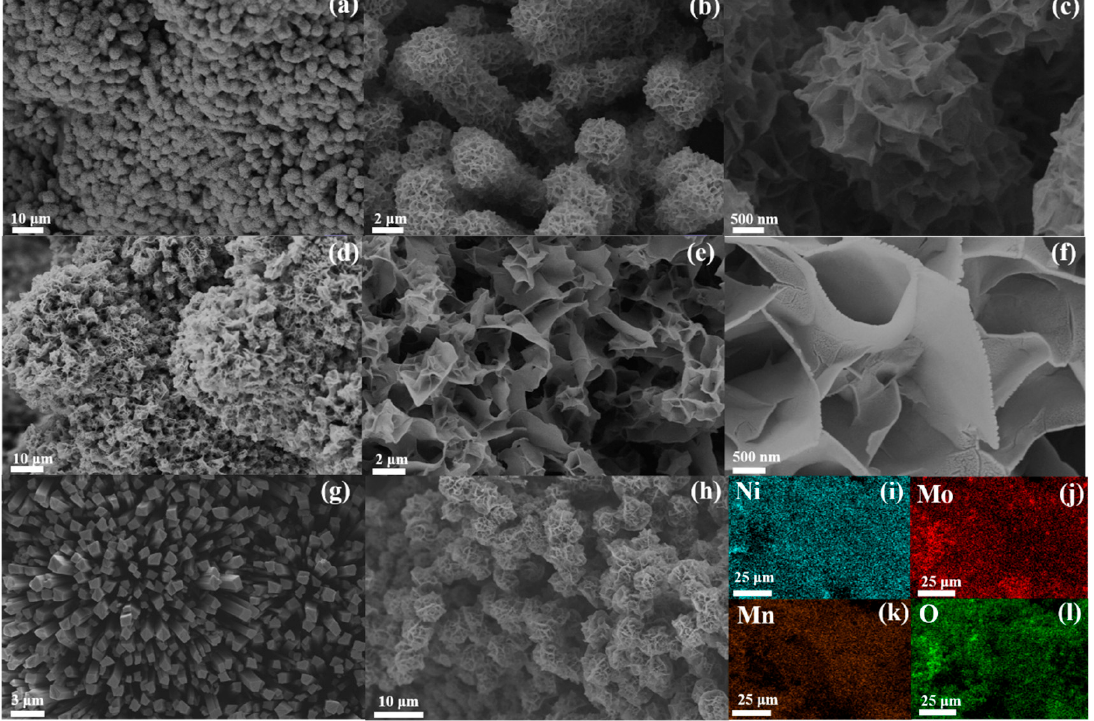
Figure 4. SEM images of ( a – c ) the Mn-doped-NiMoO 4 /NF (0), ( d – f , h ) the Mn-doped-NiMoO 4 /NF (25), ( g ) NiMoO 4 /NF/( i – l ) EDS mapping images of the Mn-doped-NiMoO 4 /NF (25).